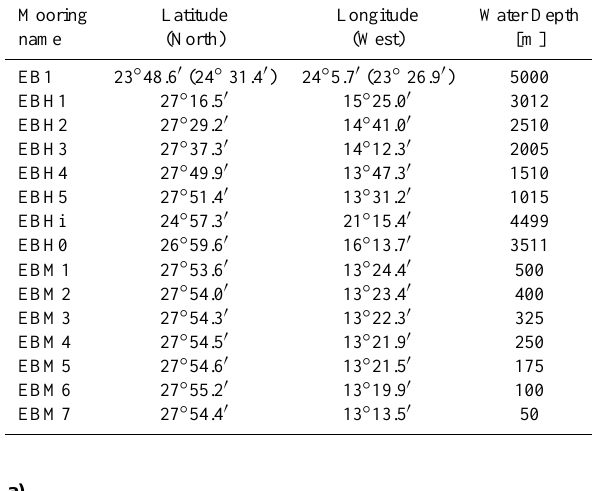
Table 1. Nominal positions and water depths of eastern-boundary moorings. Note that the position of EB1 changed slightly between the first year’s deployment (2004) and the subsequent deployments (2005 onwards). The position of EB1 corresponds to year 2005 deployment, while the position corresponding to the year 2004 is given in brackets.